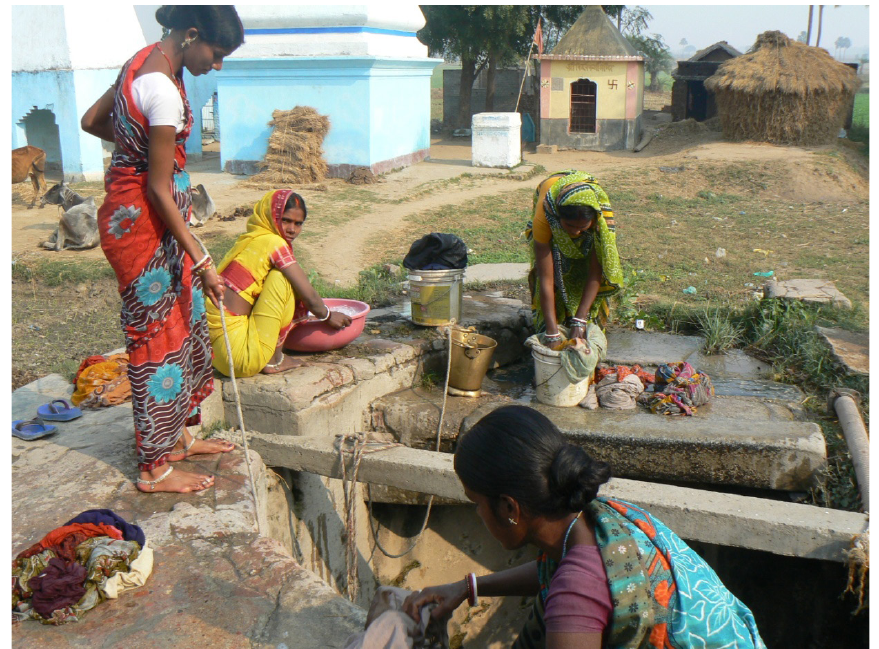
Figure 4: Non-Dalit women washing clothes at the badka kuan (March